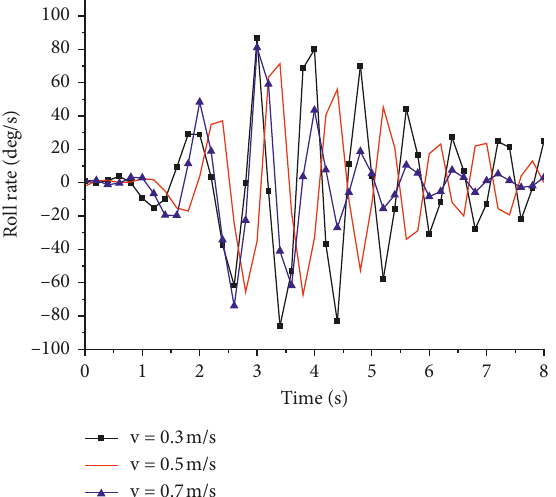
Figure 12: Ship’s roll angular velocity time-history curve at dif- ferent ship speeds.